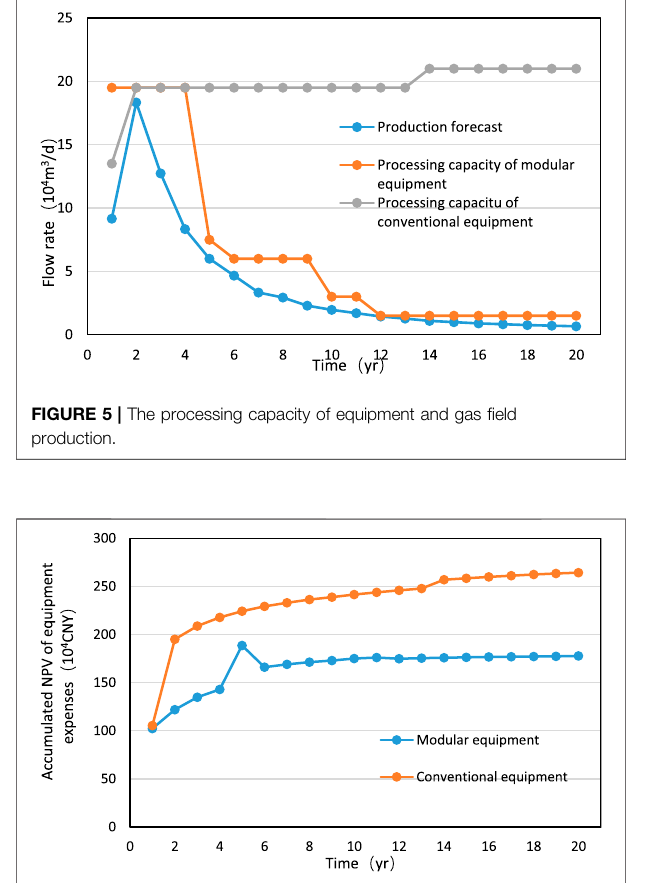
FIGURE 6 | Accumulated net present value of equipment expenses.